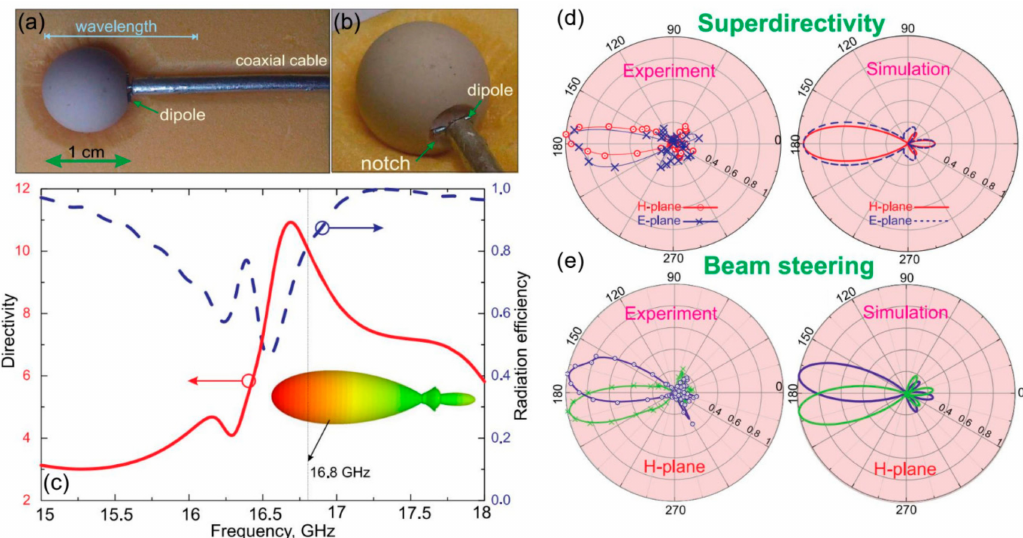
Figure 4. Superdirective dielectric antenna. ( a , b ) Photos of the realized antenna. The antenna consists of a dielectric spherical resonator of size ~ λ 0 /2.5 with a small notch and a short dipole source placed inside the notch ( b ). The dipole fed by a coaxial cable. ( c ) Results of numerical simulations of the antenna’s directivity and radiation e ffi ciency. ( d , e ) Results of experimental realization in an anechoic chamber of the superdirectivity e ff ect ( d ) and the beam steering e ff ect ( e ) and their comparison with numerical simulation results. Reprinted with permission from